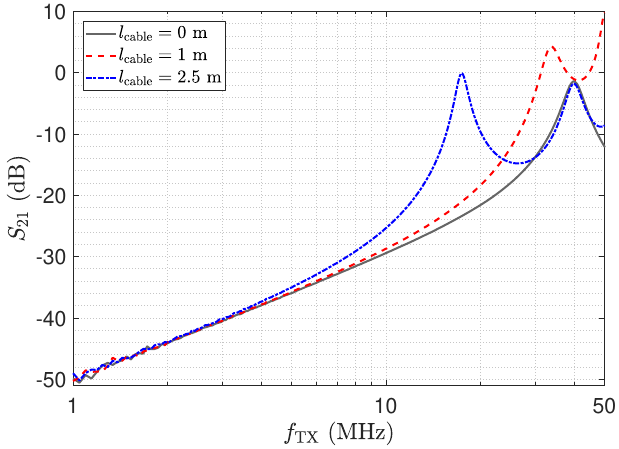
Figure 26. Measurement results for three different cable lengths of the matched version of the resonant LCR circuit shown in Figure 21. As the circuit input impedance in Figure 24 is close to 50 Ω at 40MHz, almost the same transfer coefficient is obtained at 40MHz for all three cable